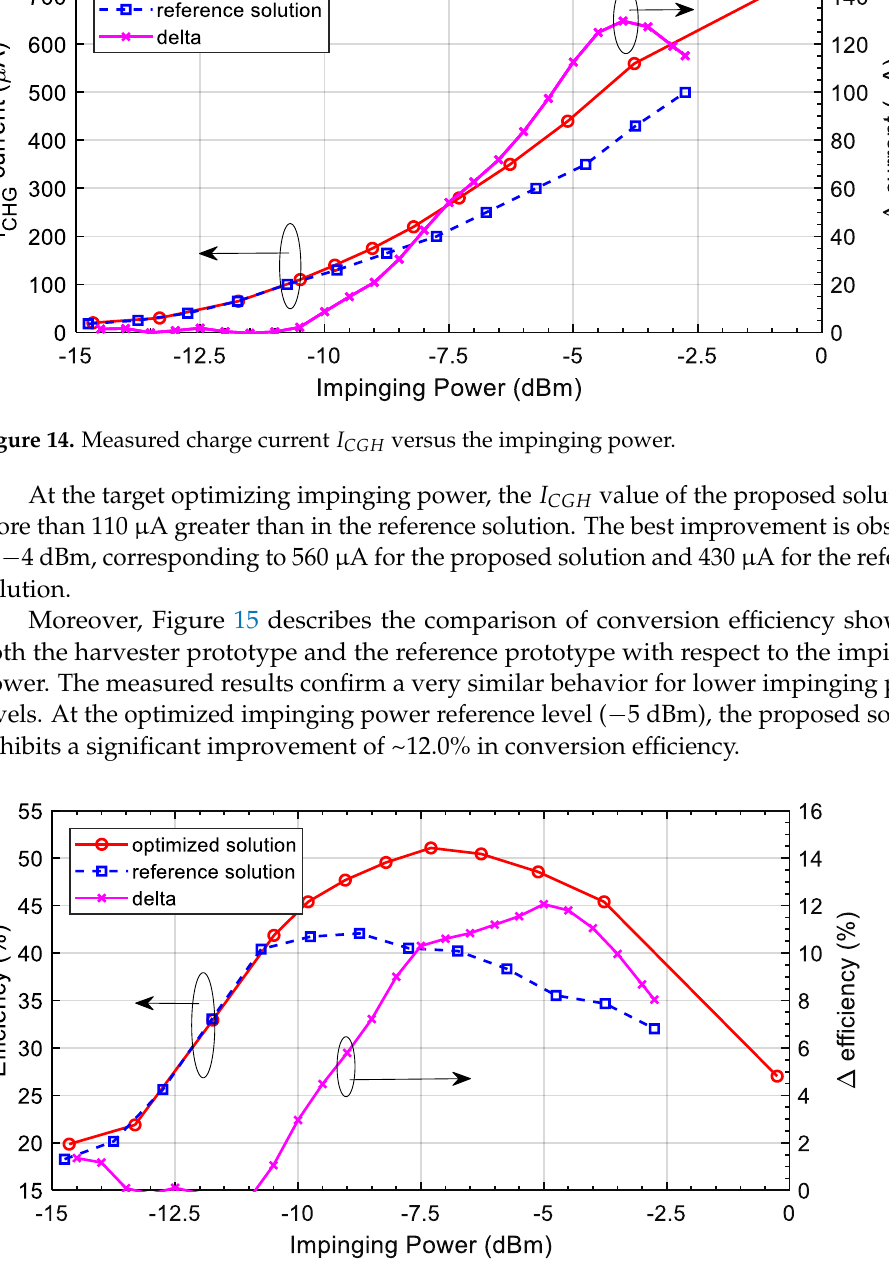
Figure 15. Measured conversion efficiency versus the impinging power.